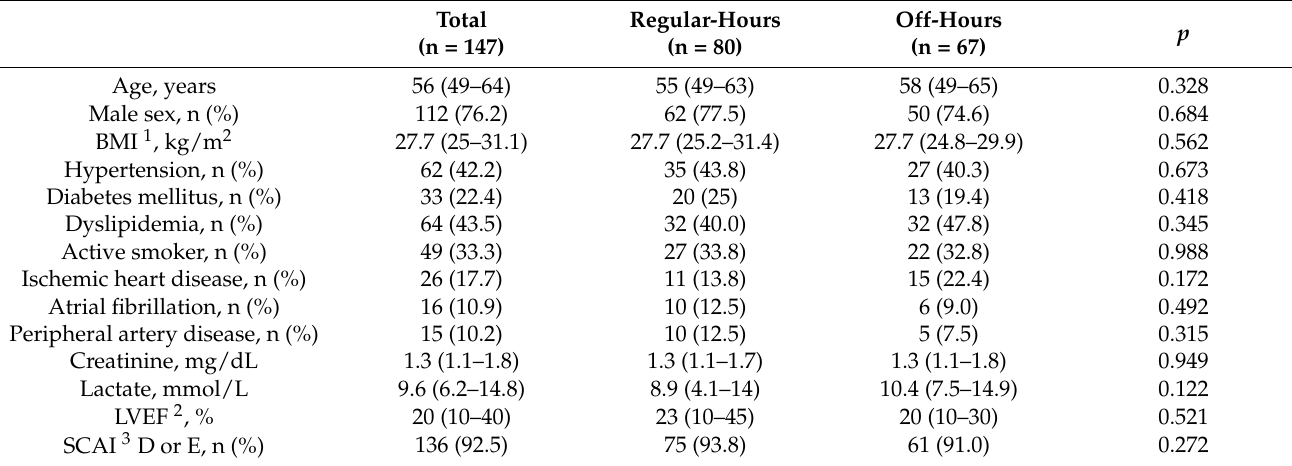
Table 1. Baseline characteristics according to the moment of venoarterial extracorporeal membrane oxygenation